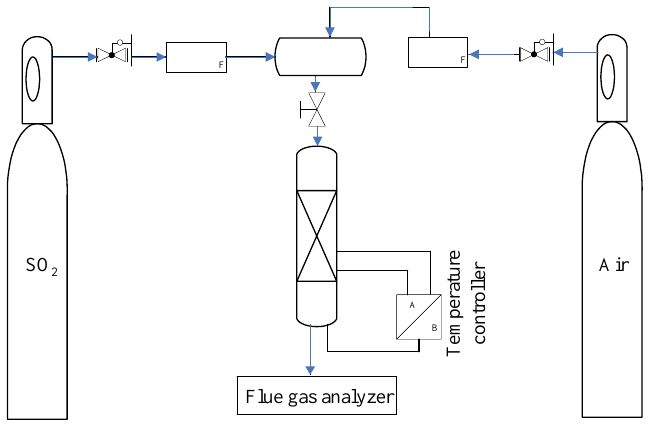
Figure 9. Experimental facility of homemade fixed-bed micro-reactor unit.